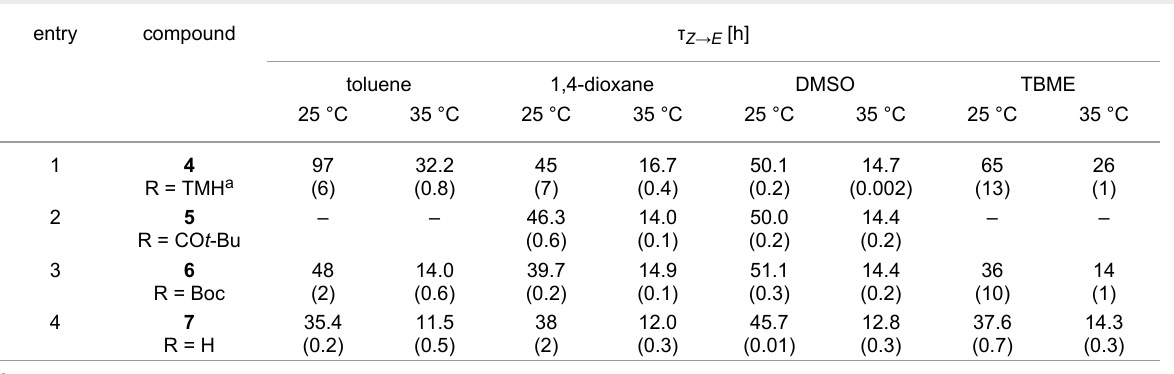
Table 2: Computational results for ( Z )-azobenzenes 4 – 7 . Δ G is the free energy of the most stable Z -conformer relative to the corresponding open ( Z )- conformation (method in parentheses, see Figure S4 in Supporting Information File 1 for graphical representations of the compared conformers). Compound Δ G relative to open conformations (B3LYP-D3(BJ) a ) [kcal mol − 1